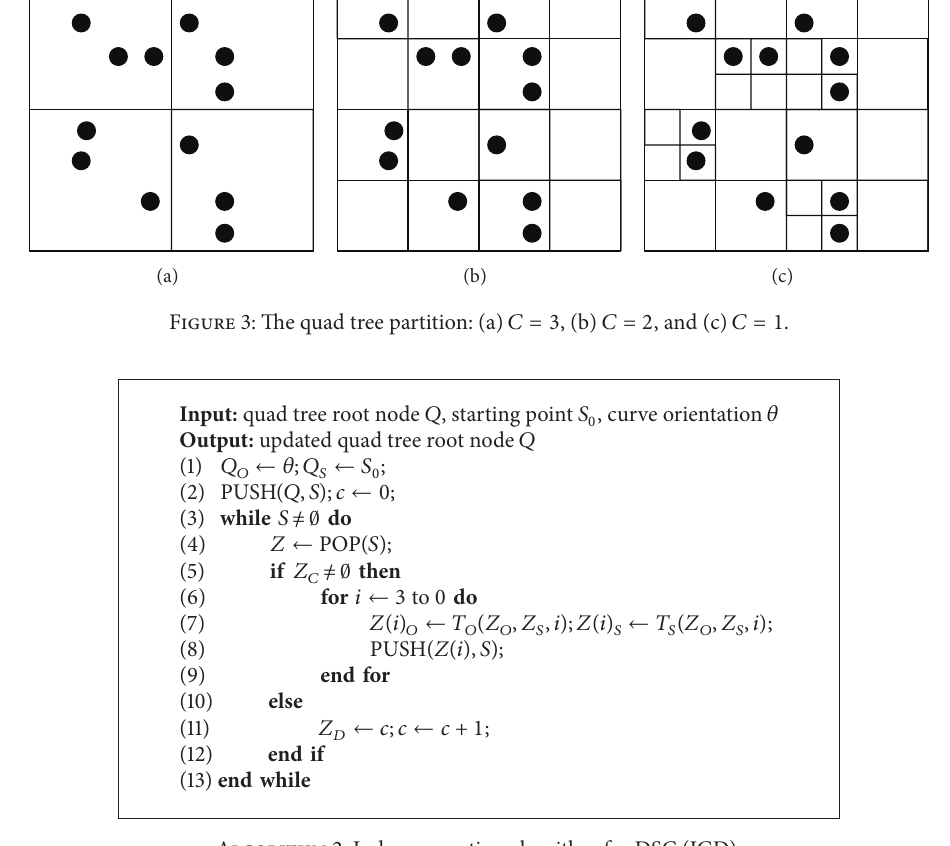
Algorithm 2: Index generation algorithm for DSC (IGD).